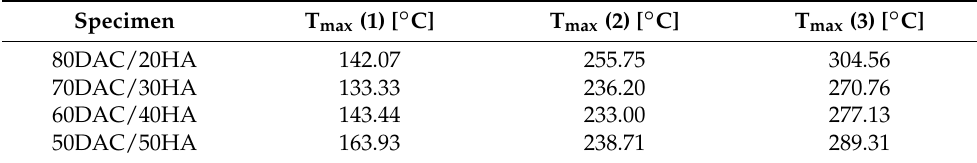
Table 1. The results of DTA analysis with temperatures of maximum